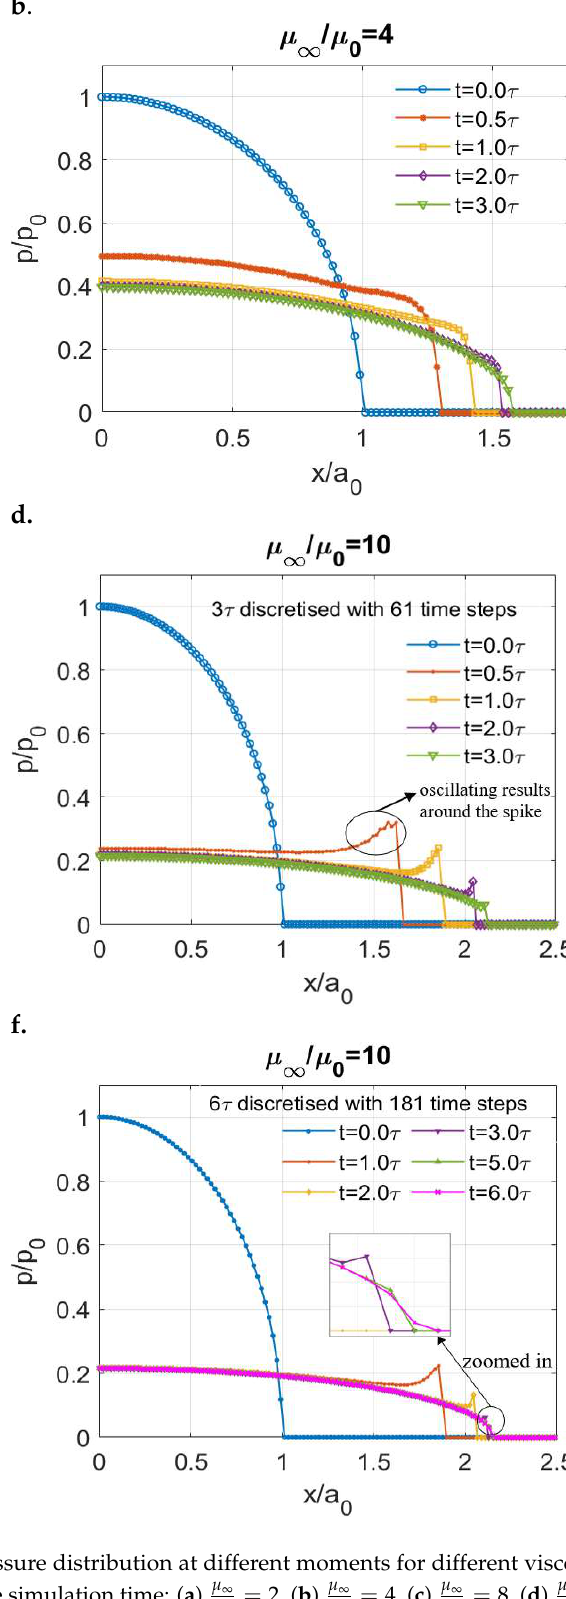
= 2, ( b ) µ ∞ = 4, ( c ) µ ∞ = 8, ( d ) µ ∞ = 10, µ 0 µ 0 µ 0 µ 0 = 10 with extended simulation (cid:3091) (cid:3246) µ 0 = 2 , ( b ) (cid:3091) (cid:3246) = 4 , ( c ) (cid:3091) (cid:3246) = 8 , ( d ) (cid:3091) (cid:3246) = 10 , (cid:3091) (cid:3116) (cid:3091) (cid:3116) (cid:3091) (cid:3116) (cid:3091) (cid:3116) = 10 with extended simulation time. (cid:3091) (cid:3116)